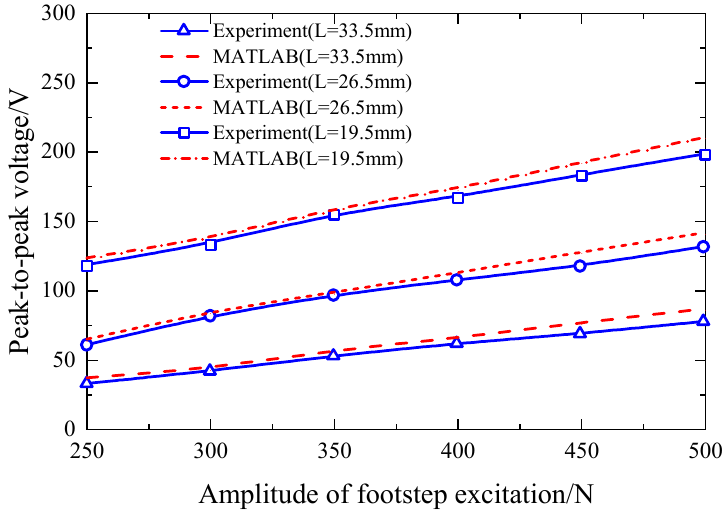
Figure 18. Peak-to-peak voltages of 1#1 PZT4 patch of unimorph PCS from simulation and experi- ment versus the amplitude of footstep excitation. Table 6. Output electric parameters of 1#1 PZT4 patches on unimorph PCS with different substrate materials.